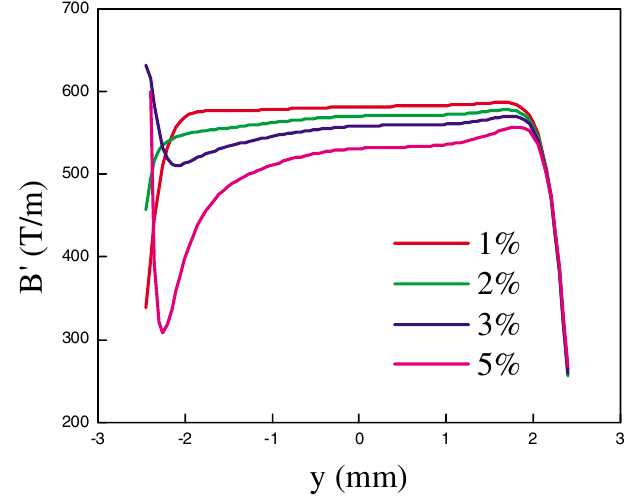
FIG. 5. (Color) Field gradient dependence on magnet wedge shape errors. Each curve represents wedge shape (mechanical) deviation from the ideal.